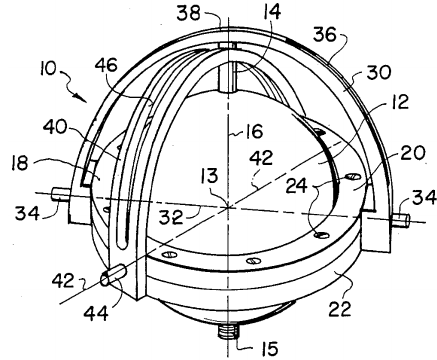
Figure 18. Spherical wrist joint